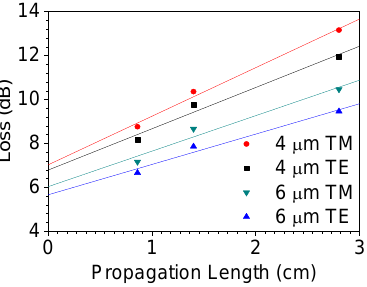
Figure 6. Insertion loss measurement results using cut-back method.